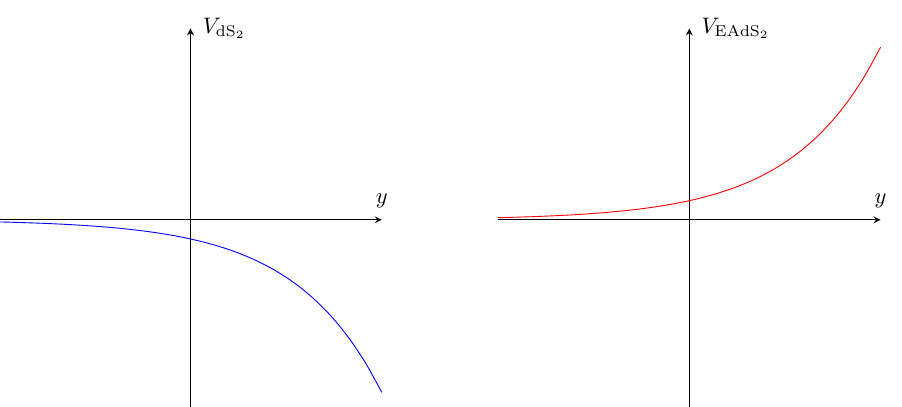
Figure 1 . The de Sitter potential V the Euclidean AdS potential V